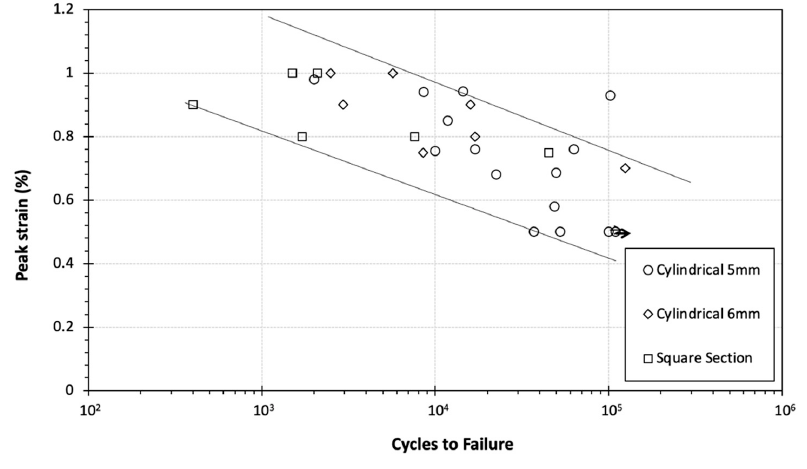
Figure 9. Strain controlled fatigue data.